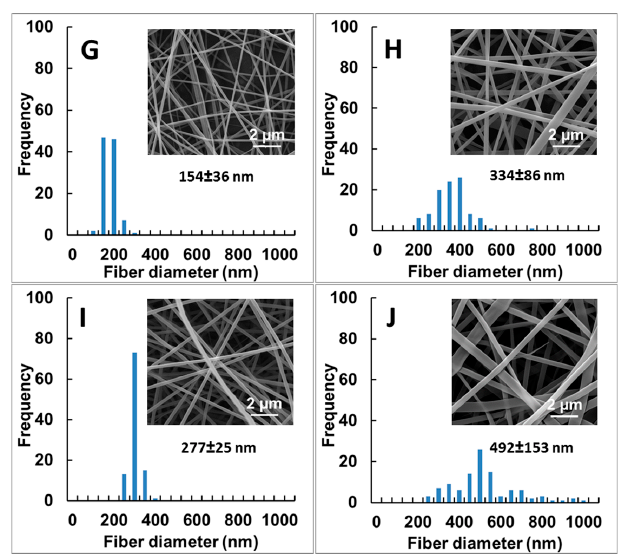
Figure 1. Size and size distribution of pullulan (PUL) fibers electrospun from PUL solutions with different types and concentrations and salts shown in the respective SEM image: 8% PUL without salt ( A ); and with NaCl at 0.20 M ( B ) and 1.0 M ( C ); 15% PUL without salt ( D ); and with NaCl at 2.0 M ( E ) and 5.0 M ( F ); 8% PUL with Na 3 C 6 H 5 O 7 at 0.05 M ( G ) and 0.50 M ( H ); 15% PUL with Na 3 C 6 H 5 O 7 at 0.05 M ( I ) and 0.50 M ( J ). Magnification is 25,000×.